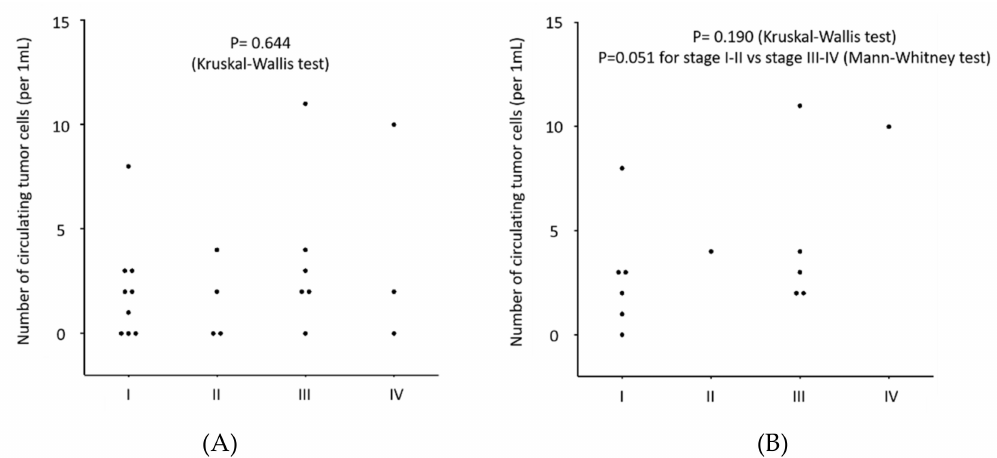
Figure 7. ( A ) Distribution of the number of circulating tumor cells (CTC-count) detected with the CTC-chip in 1 mL of peripheral blood sampled form patients with malignant pleural mesothelioma (MPM) according to clinical stage. The CTC-chip was coated with an anti-podoplanin antibody (clone NZ-1.2) to capture CTCs. ( B ) Distribution of the number of circulating tumor cells (CTC-count) detected with the CTC-chip in 1 mL of peripheral blood sampled form patients with epithelioid malignant pleural mesothelioma (MPM) according to clinical